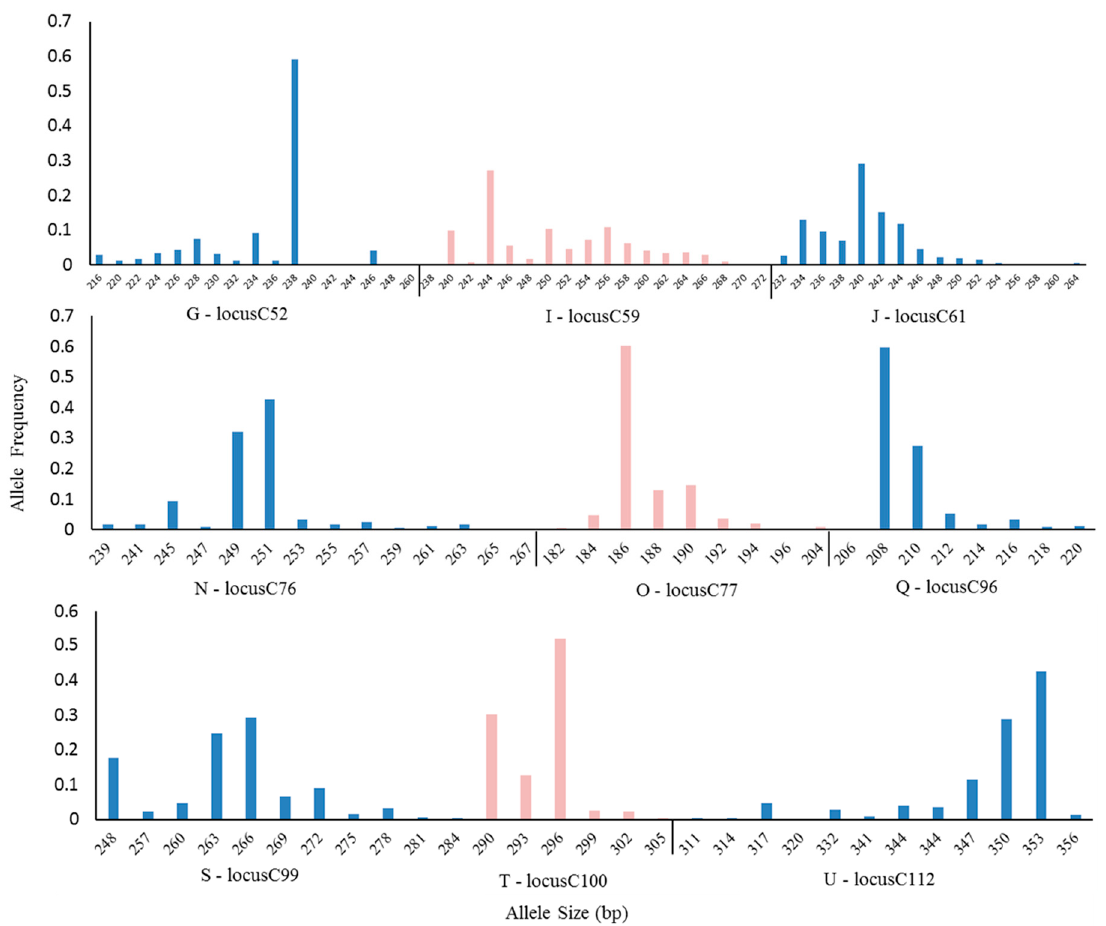
Figure3. Allelesizesandfrequenciesfornine-markercombinationin261accessionsof Salixpsammophila Figure 3. Allele sizes and frequencies for nine-marker combination in 261 accessions of Salix psammophila .